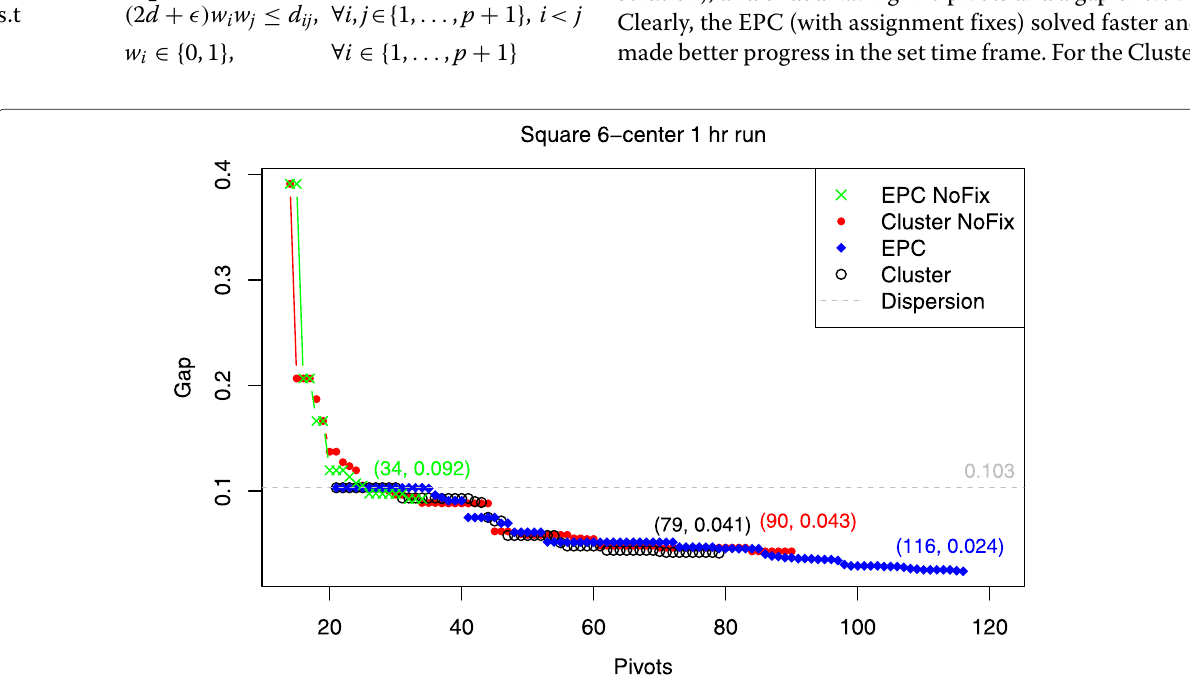
Fig. 6 Performance comparison of different algorithmic